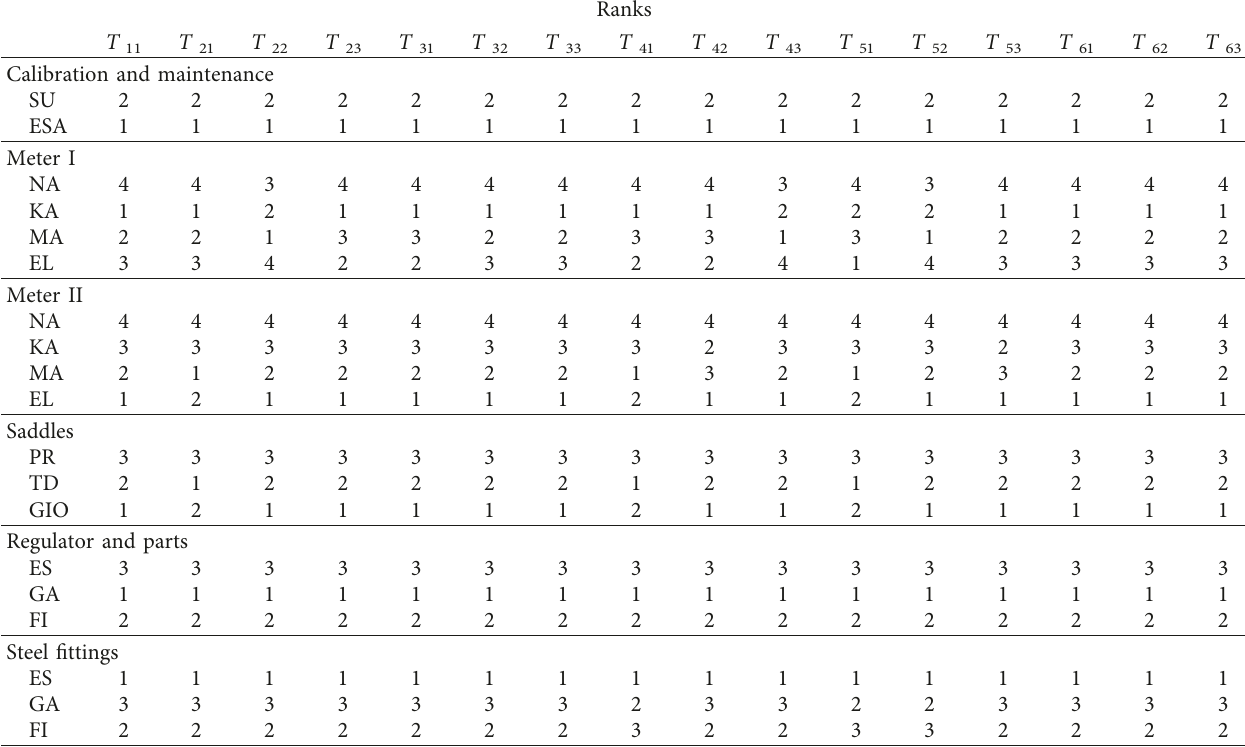
Table 13: Variance of final ranks of alternatives.